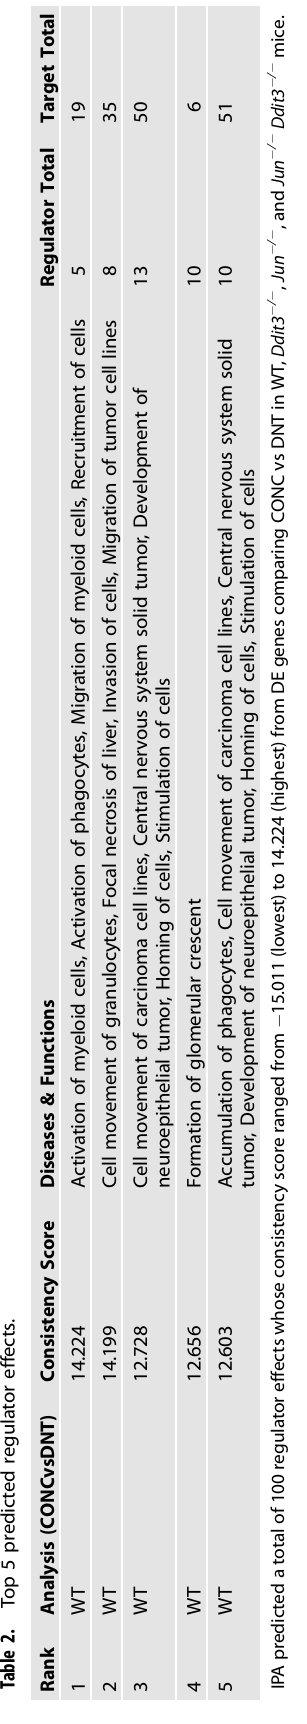
Cell Death and Disease (2022)